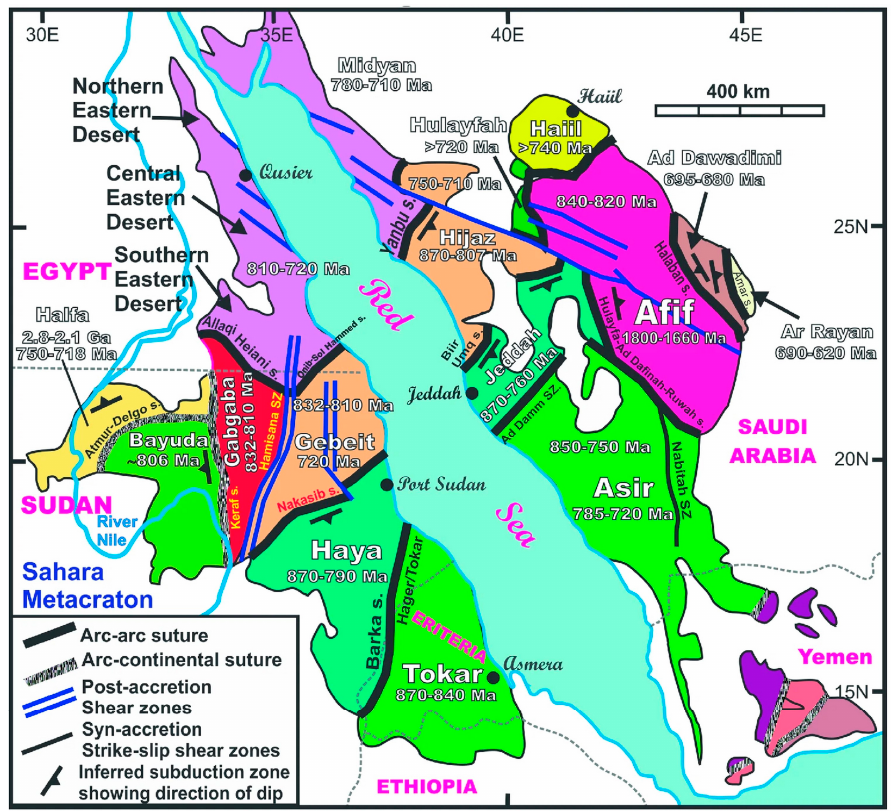
Figure 2. Tectonic map of the ANS showing the locations and extents of terranes, sutures and post-accretionary structures